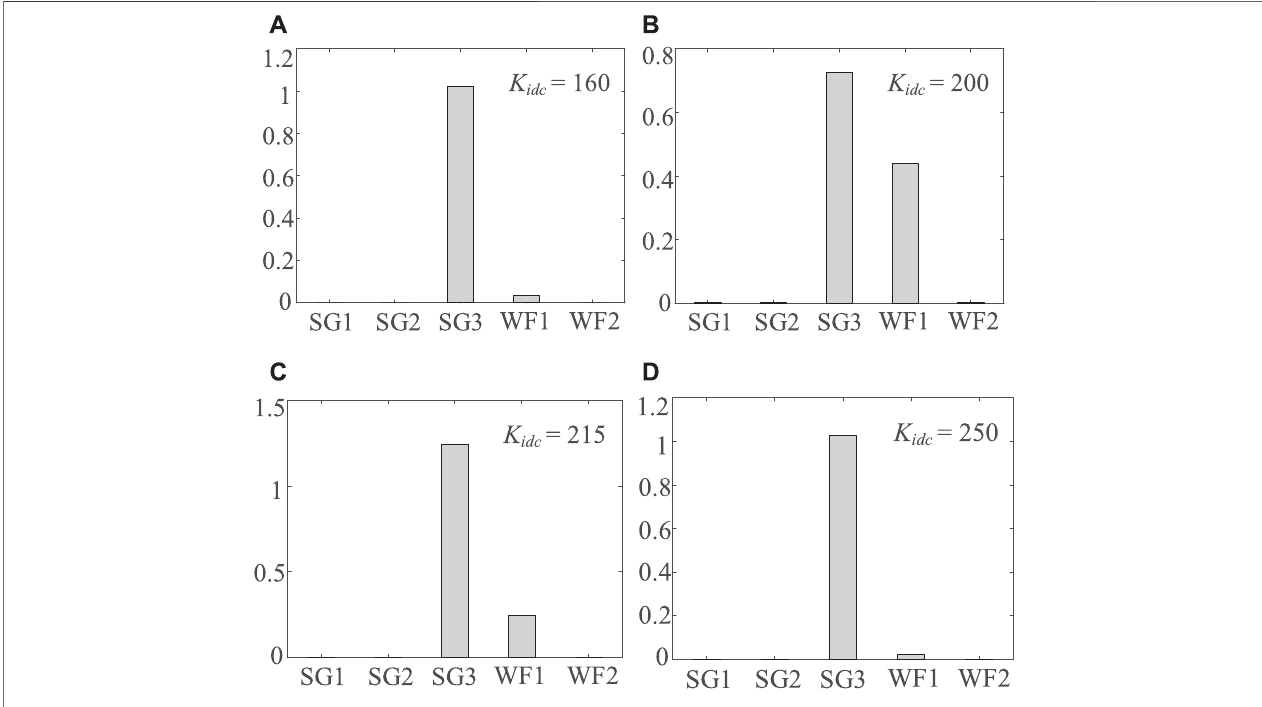
Frontiers in Energy Research |